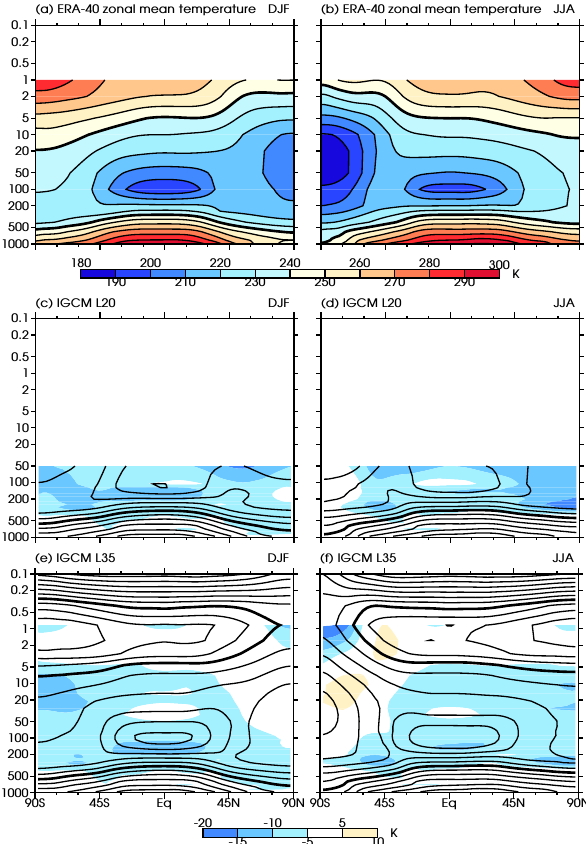
ence between IGCM4 L20 and ERA (c, d) and difference between IGCM4 L35 and ERA (e, f) in colour shading. In all subfigures con- tours show the total zonal mean temperature field (contour interval is 10K, 240K contour thicker). In all cases the left-hand panels display results for the DJF season, and the right-hand panels dis- play results for JJA season. For the reanalysis a mean over the years 1958–2002 is